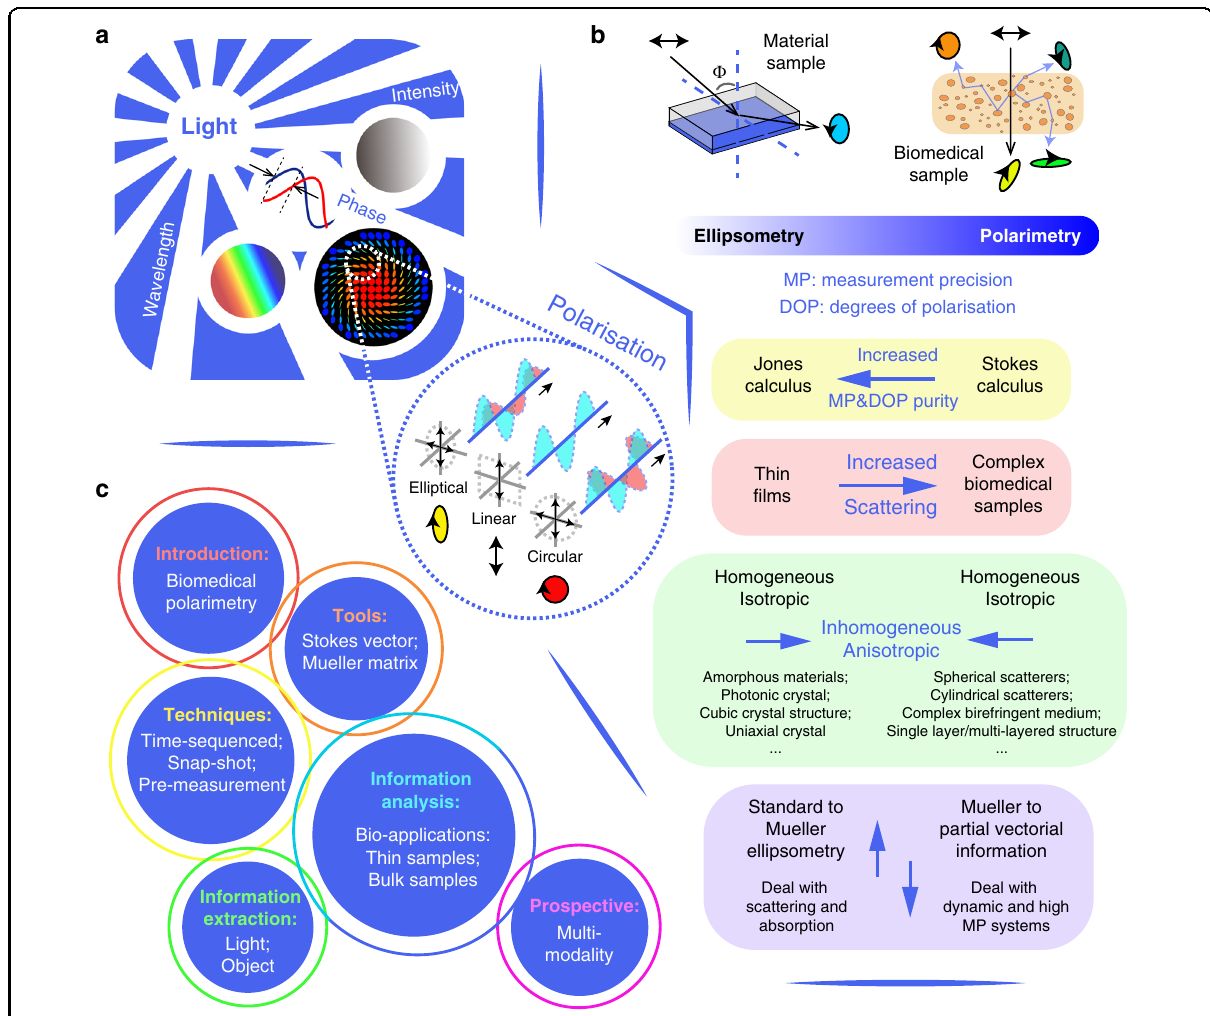
Fig. 1 Developing trends of tissue polarimetry and the structure of this review. a Light properties: intensity, wavelength, phase and polarisation. b The comparisons of the development of modern ellipsometry and polarimetry. The inset blue arrows in different colour boxes represent either changing directions or developing trends. c The structure of this